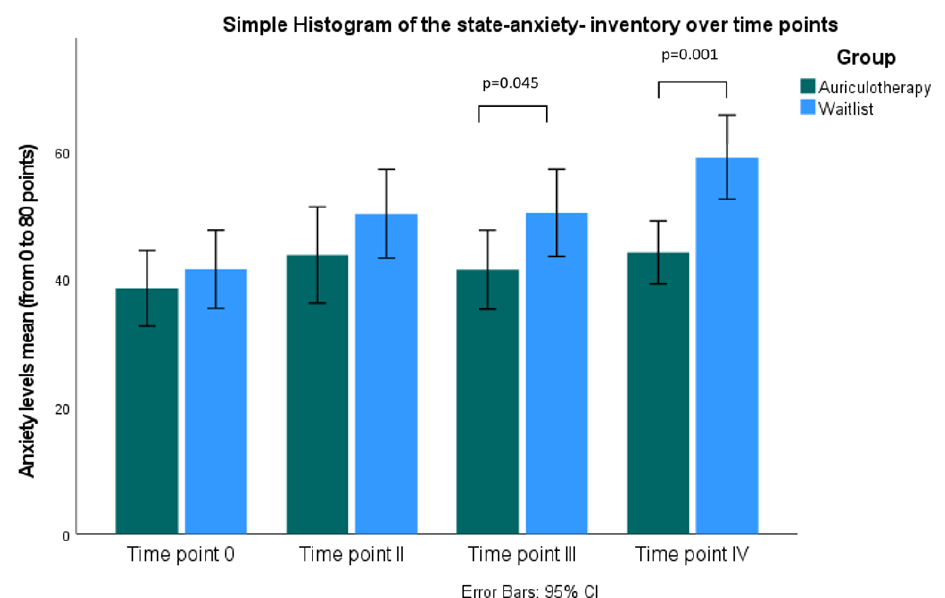
Figure 5. Histogram of separate anxiety levels measured using state anxiety inventory for both groups by independent samples t -test Time point 0: 4 weeks prior exam; Time point II: before auriculotherapy; Time point III: 30 min after auriculotherapy and Time point IV: morning before examination, CI: confidence interval.